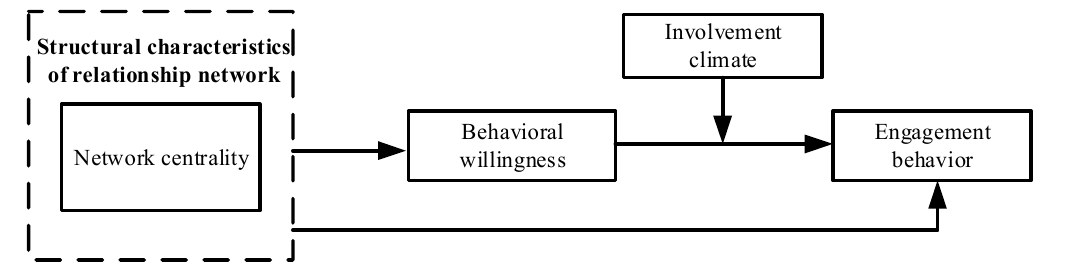
Figure 3. A theoretical model of stakeholder engagement behavior occurrence from the perspective of network embeddedness.